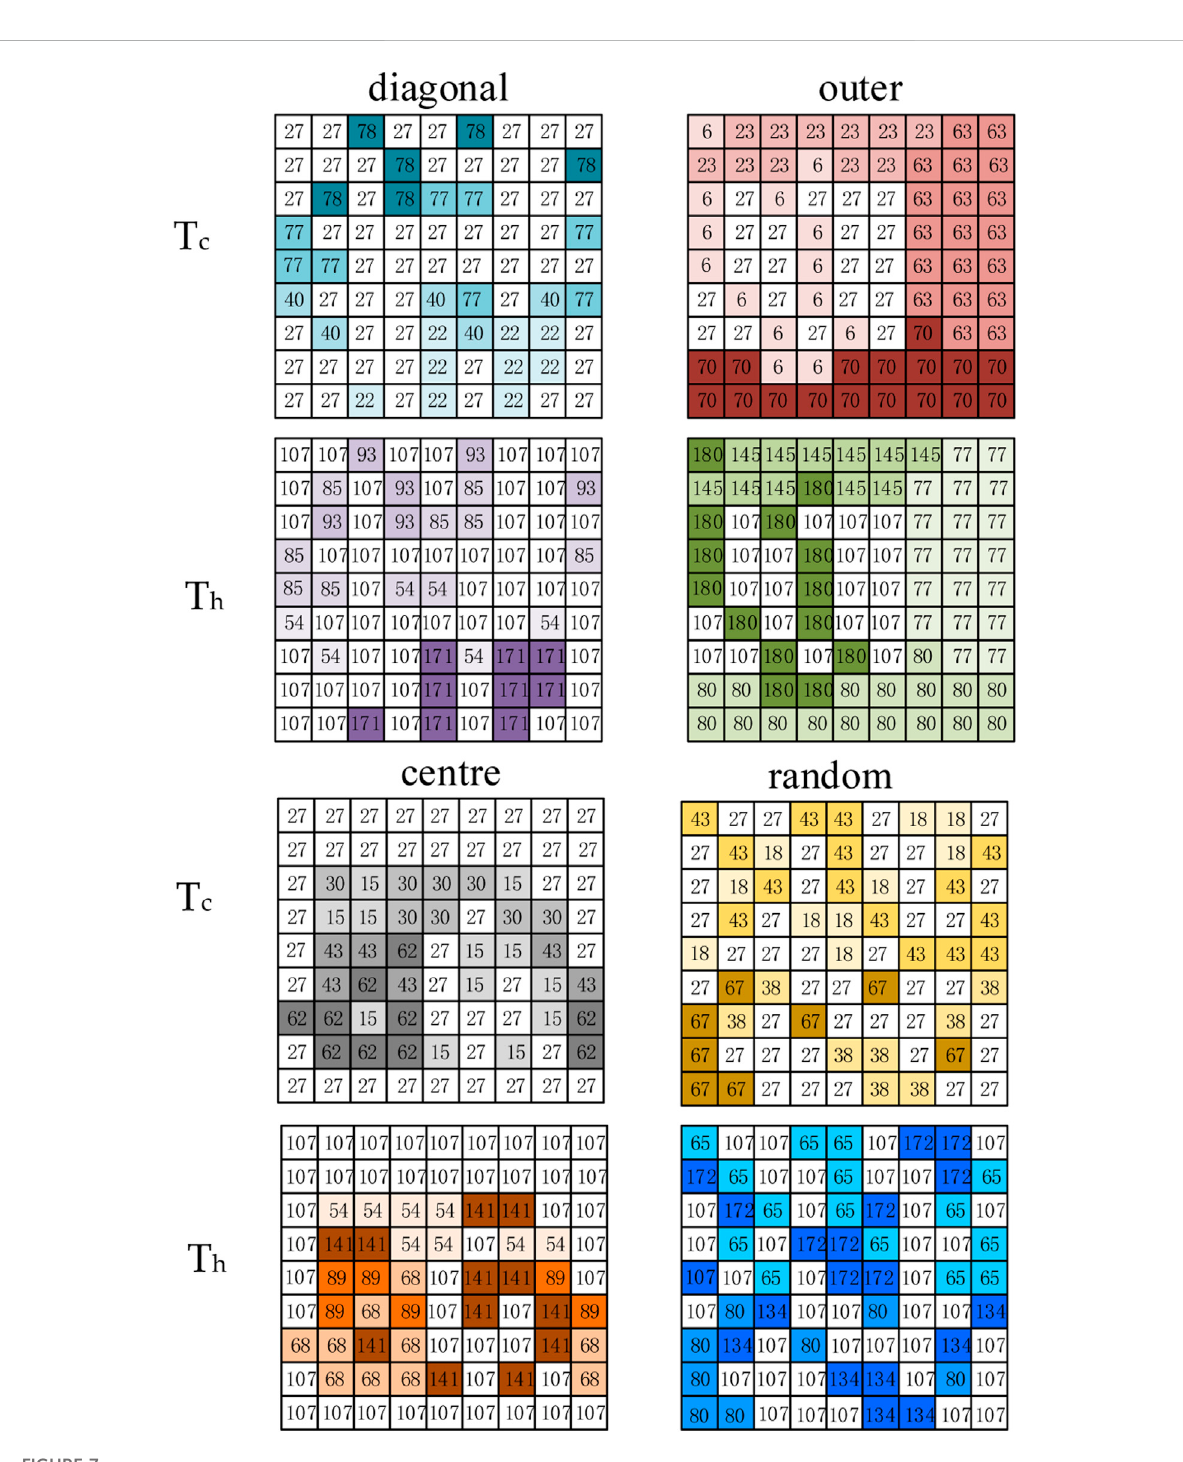
FIGURE 7 Four NTD patterns in the 9 × 9 symmetric TEG array after recon fi